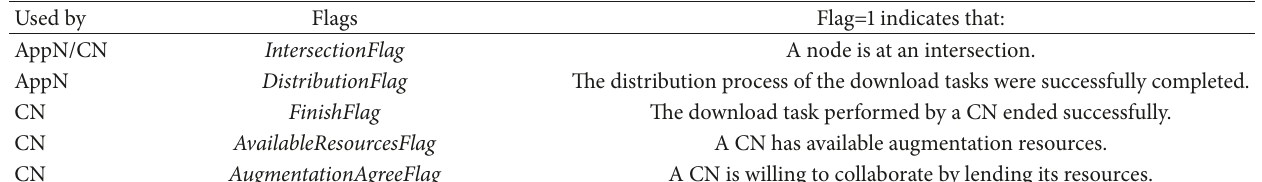
Table 3: List of flags used in our S-CMA approach.